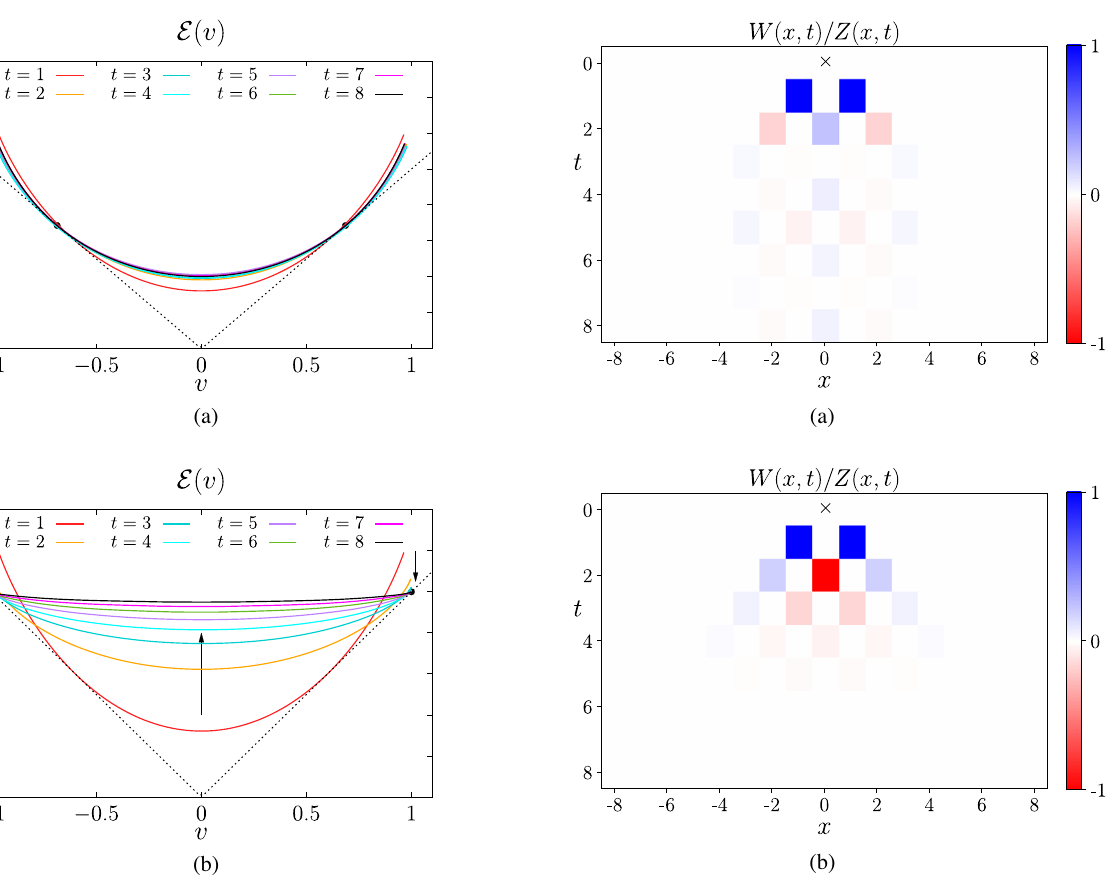
FIG. 9. The spacetime structure of W ð x; t Þ =Z ð x; t Þ for (a) the FIG. 8. Numerical calculations of E ð v Þ for Floquet Ising generic reflection-symmetric gate in Eq. (71) [Fig. 7(a)] and models. (a) shows the parameters in Eq. (80). (b) shows the (b) the maximally entangling dual-unitary gate specified in “ dual-unitary ” parameter values in Eq. (81). The bottom arrow in Eq. (81) [Fig. 8(b)]. The cross marks the coordinate (0,0). In case (b) illustrates the convergence to the expected limiting form our construction, only steps with even x þ t are E ð v Þ ¼ 1 . The intersections with the line E ð v Þ ¼ j v j are in good 1 (top arrows). agreement with the known value v B ¼